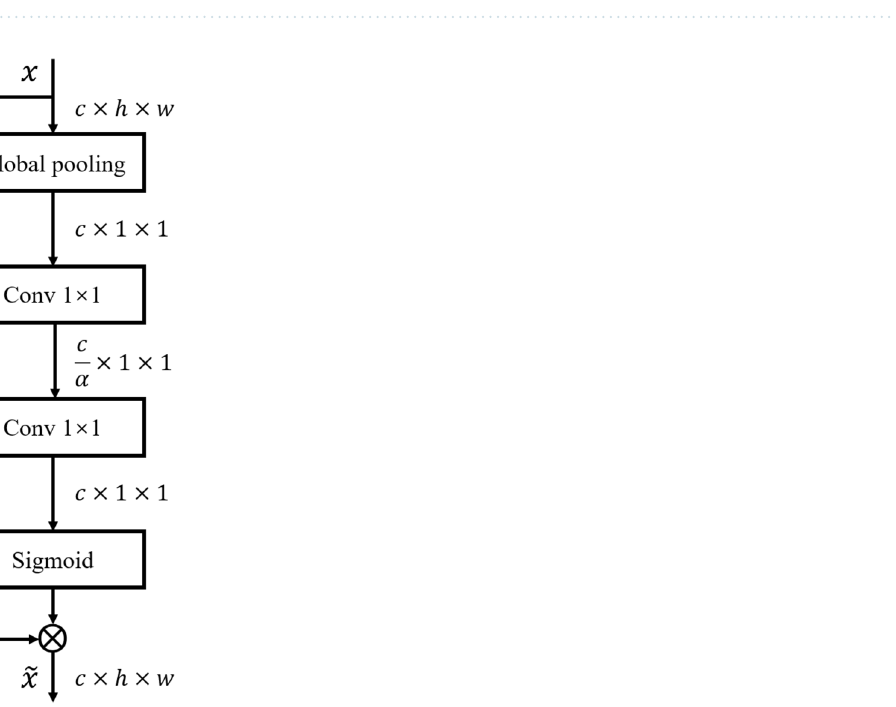
Figure 2. With a UNet-like architecture, the Generator network structure contains three convolutional downsampling layers and three transposed convolutional upsampling layers. The network aggregates information from the lower feature maps via skip connections, with an intermediate layer containing a Squeeze Excitation (SE) module and an Involution module to enhance feature extraction. *Inspired by StyleGANv2 29 , we remove the IN layer ⋆ to eliminate artifacts that may appear in the generated image.